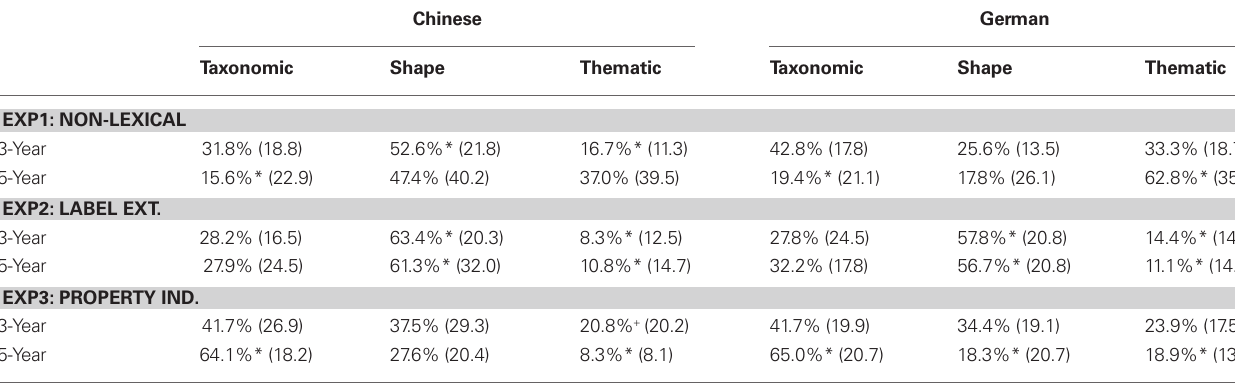
Table 2 | Mean frequency, standard deviation, and percentages of choices in each task, language, and age.